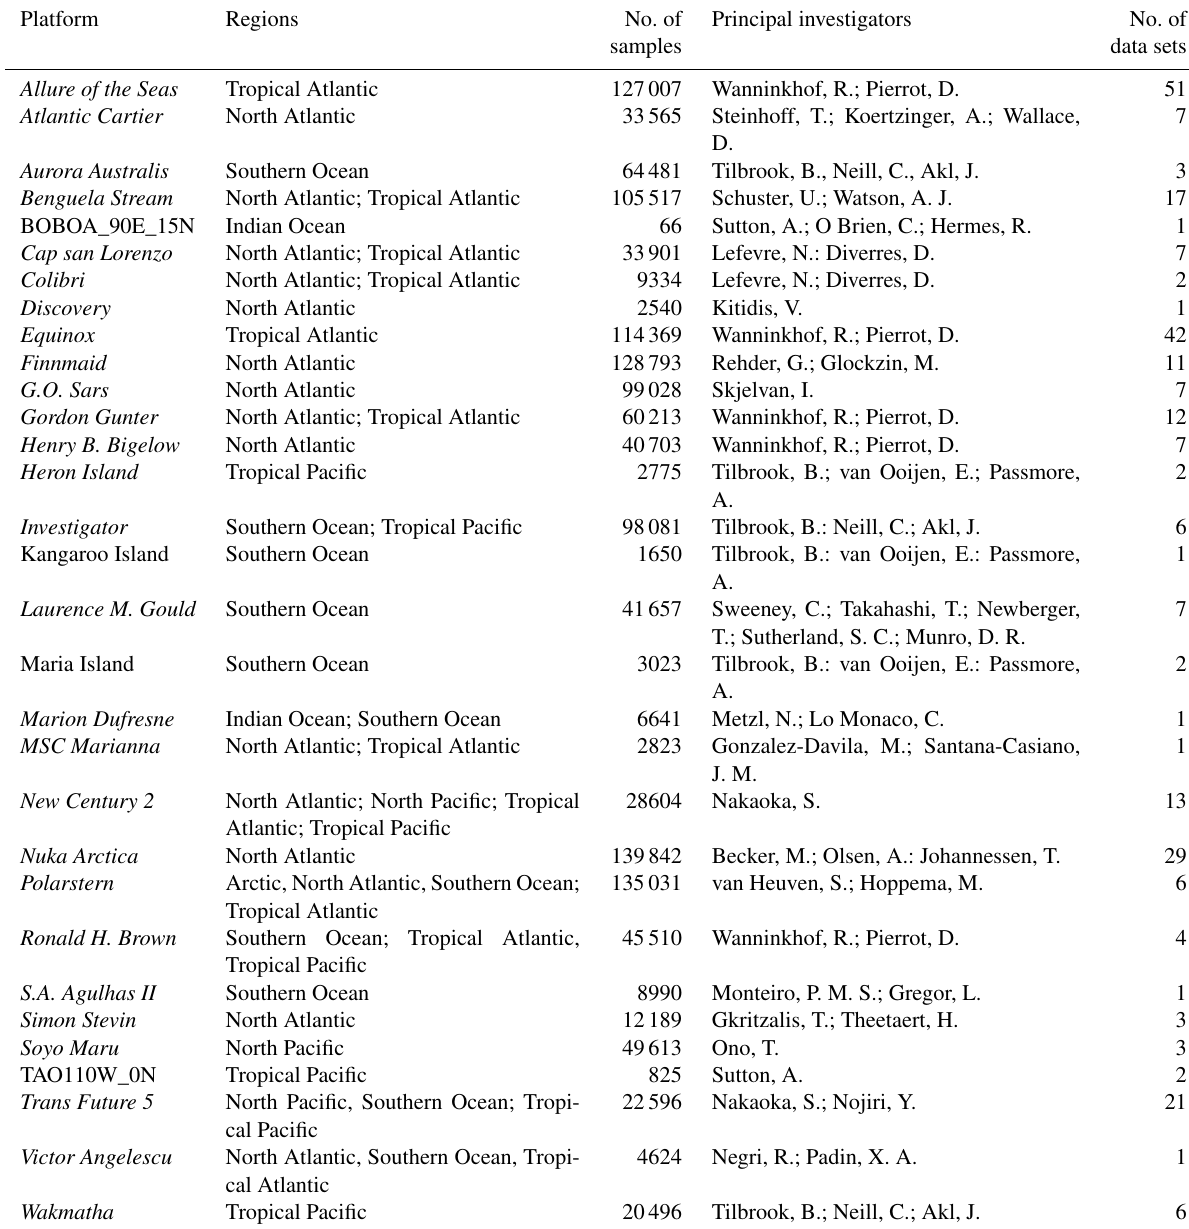
Table A4. Attribution of f CO 2 measurements for the year 2017 included in SOCAT v6 (Bakker et al., 2016) to inform ocean p CO 2 -based flux